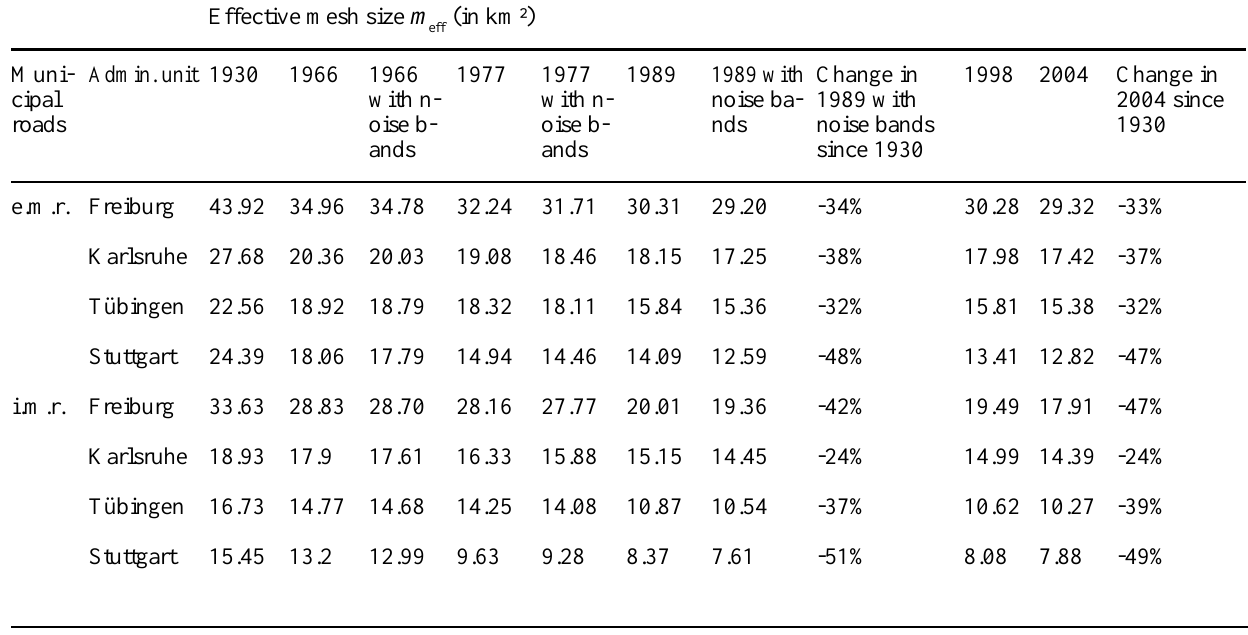
Table 2. Data on the development of the degree of landscape fragmentation in the four main administrative units of Baden-Württemberg (e.m.r. = excluding municipal roads; i.m.r. = including municipal roads; for the years 1966, 1977, and 1989, a comparison with/without noise bands was included). All values are based on the cutting-out (CUT)